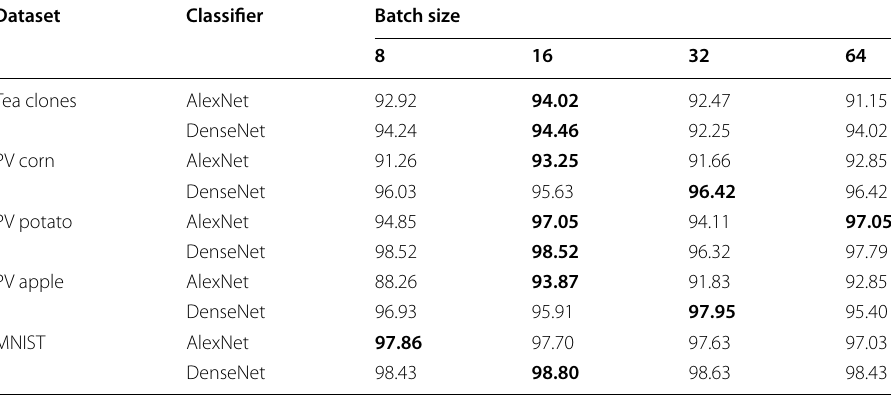
The best performance for each dataset and classifier is printed in bold